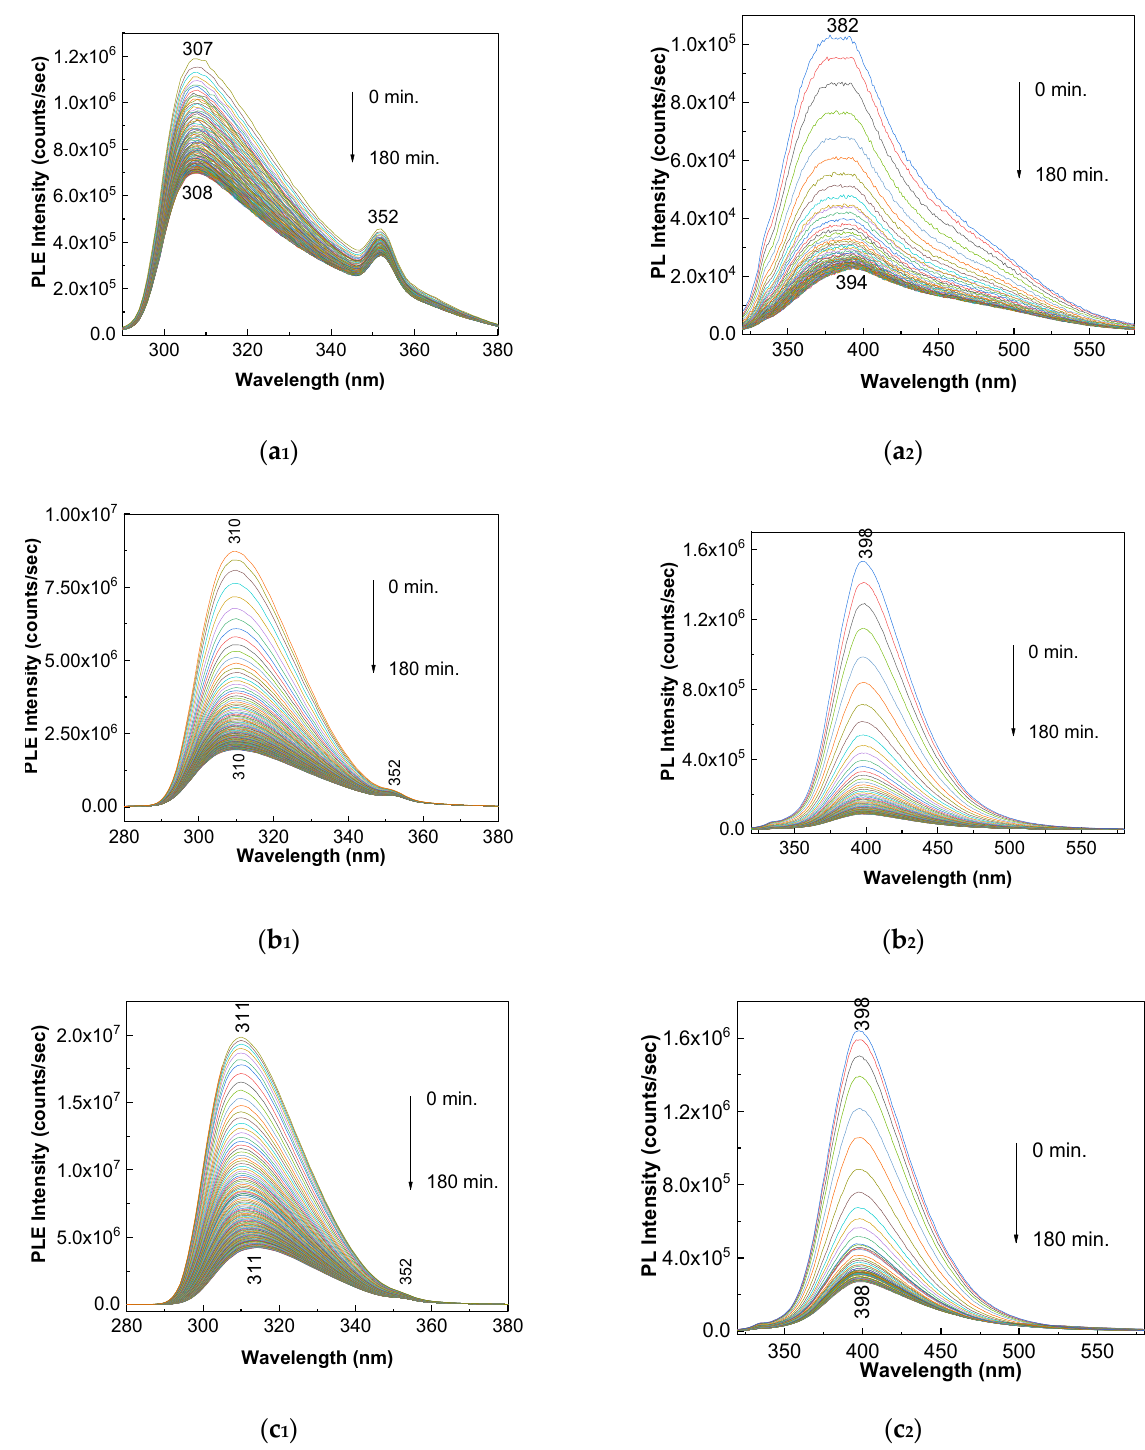
Figure 7. PLE and PL spectra of NaOH-reacted LP ( 1 ), the volumetric ratio of the LP ( 1 ) and NaOH is equal to: 2:1 ( a 1 , a 2 ), 1.5:1.5 ( b 1 , b 2 ) and 1:2 ( c 1 , c 2 ), and their evolution under UV light.